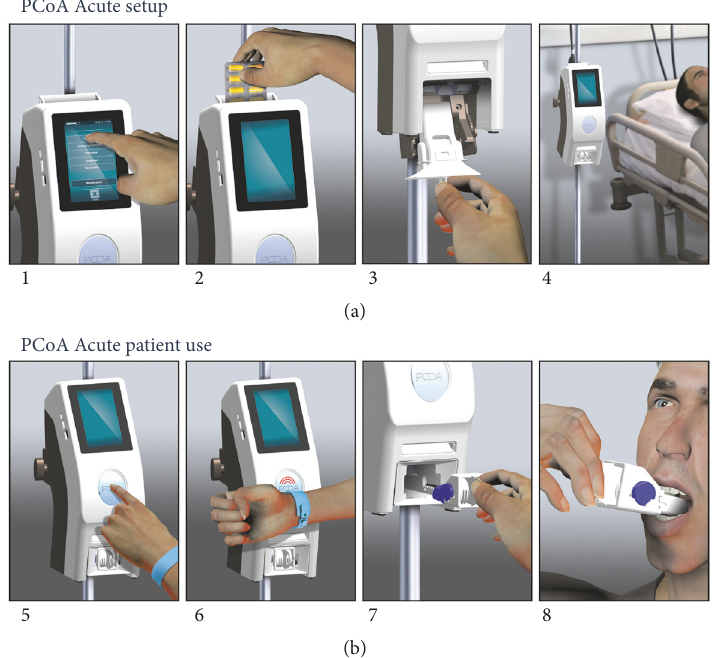
Figure 1: PCoA Acute device application. (a) Device setup by the nurse. (1) Patient’s prescription is programmed into the device and displayed on the touch screen. (2) Drug blister pack is inserted into the Drug Dispensing Unit (DDU). (3) Disposable PillBox with integral mouth piece is inserted in the device. (4) The device is located near the patient’s bedside. (b) Patient use. (5) Patient requests pill when needed by pushing a button. (6) Patient identity is confirmed by registration of RFID wristband. (7) Patient withdraws the PillBox. (8) Patient receives pill by application of light sucking pressure on the PillBox